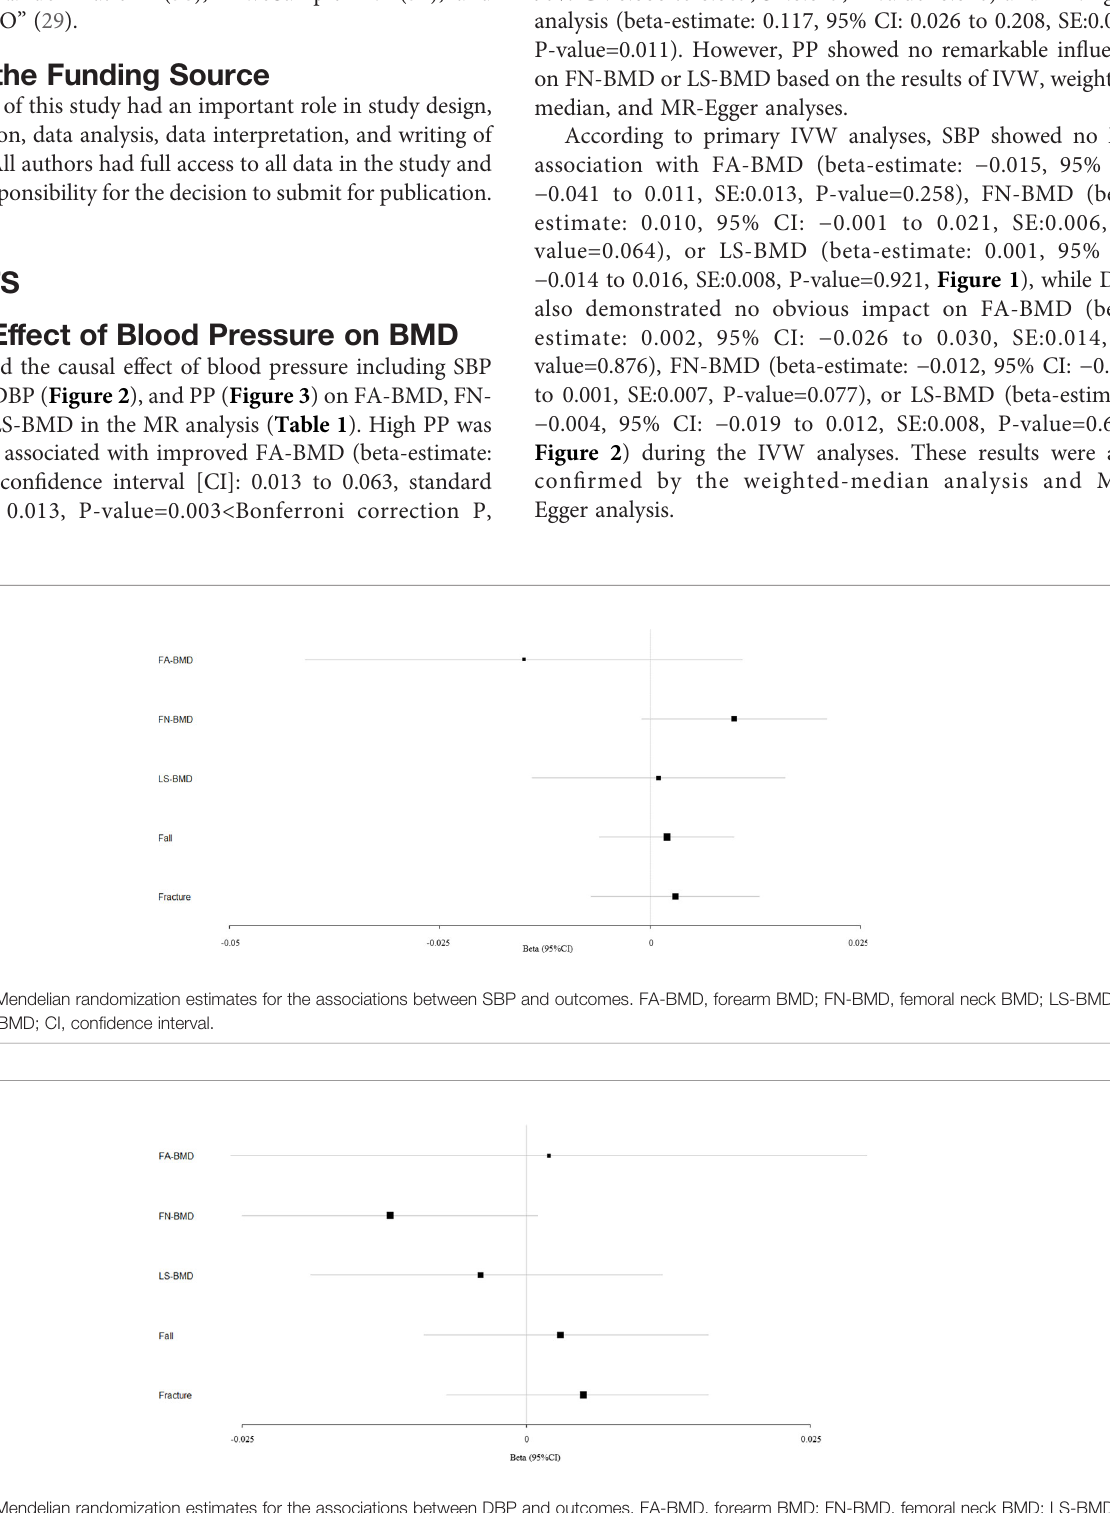
FIGURE 2 | Mendelian randomization estimates for the associations between DBP and outcomes. FA-BMD, forearm BMD; FN-BMD, femoral neck BMD; LS-BMD, lumbar spine BMD; CI, con fi dence